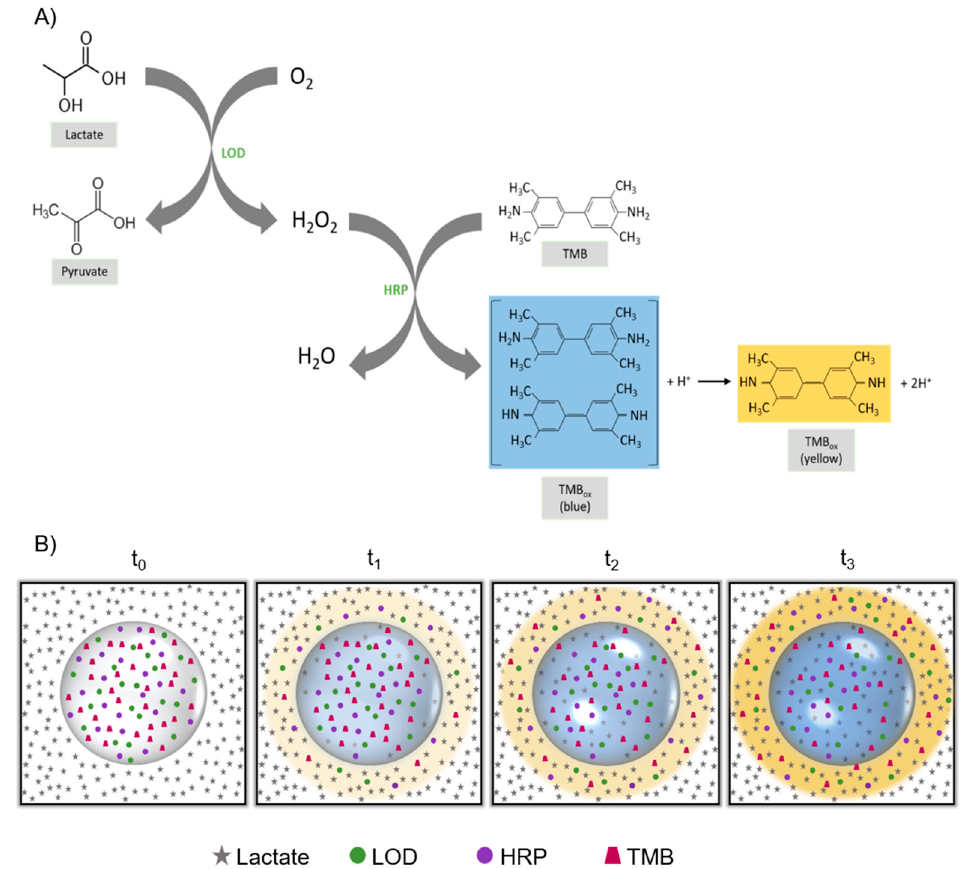
Figure 1. Enzymatic assay reaction when the components are integrated into the alginate bead sensor for lactate sensing. ( A ) Enzymatic cascade for lactate detection. The LOD oxidises the lactate present in sweat to pyruvate, yielding hydrogen peroxide, which is later used as the electron donor for the HRP. This enzyme performs the oxidation of TMB, yielding a blue-coloured product, which can be further oxidised in a two-electron oxidation as more hydrogen peroxide is generated, obtaining an orange/yellow-coloured product. ( B ) Schematic diagram of the alginate beads during lactate sensing over time (t 0 –t 3 ).